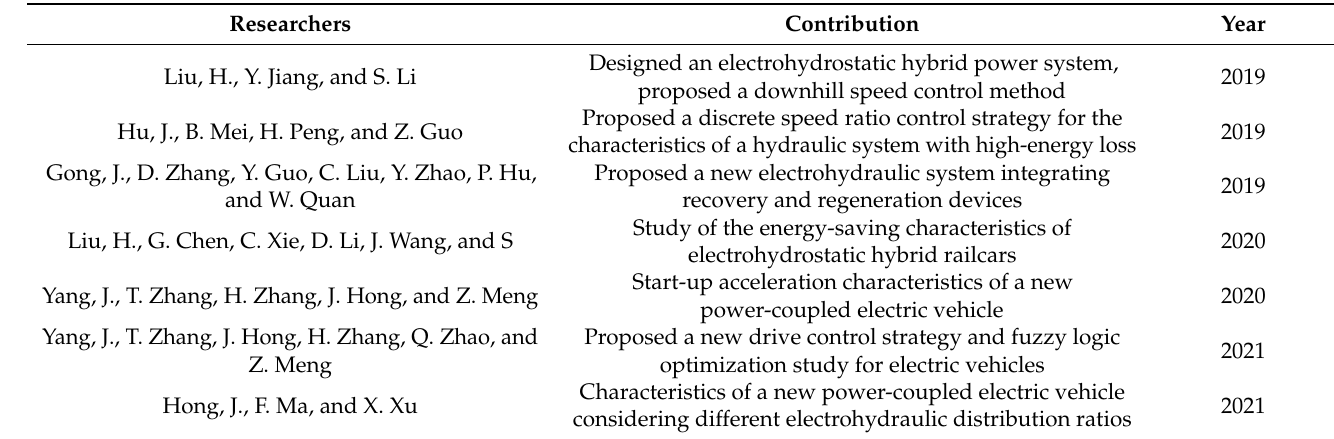
Table 1. Summary of the